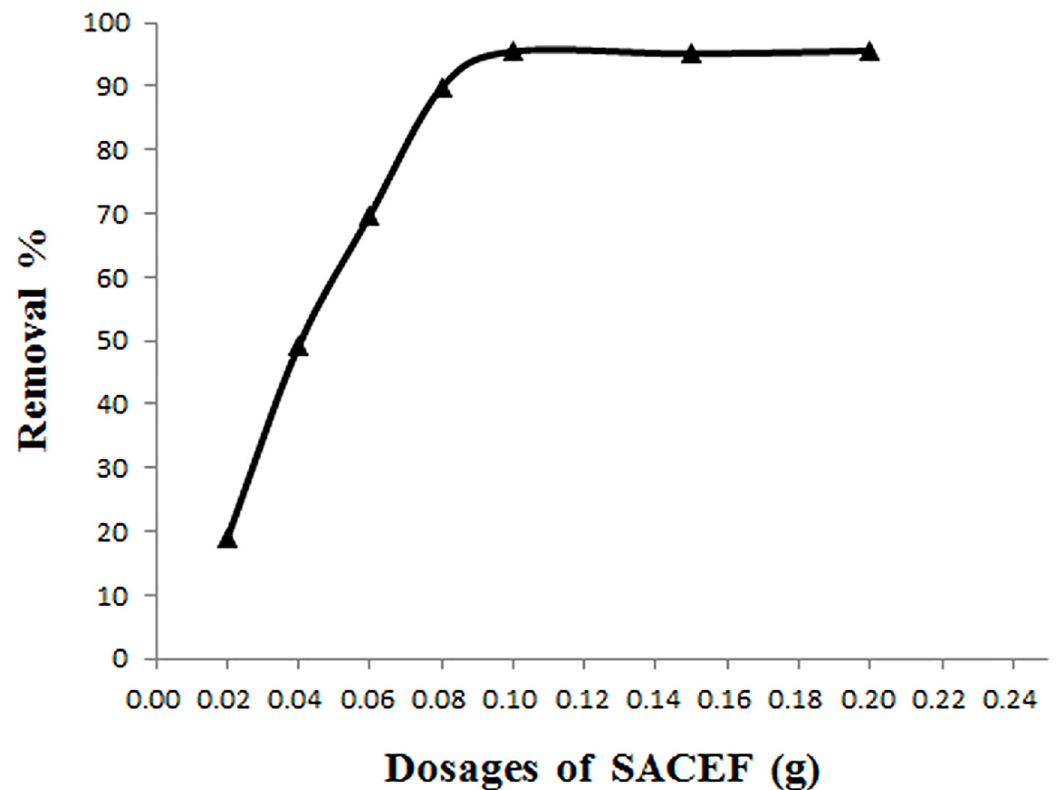
Fig 2. The effect of SACEF dosage on the percentage removal of reserpine. (experimental conditions: c 0 = 100 mg/L, T = 303 K, pH = 5 and contact time = 90min).